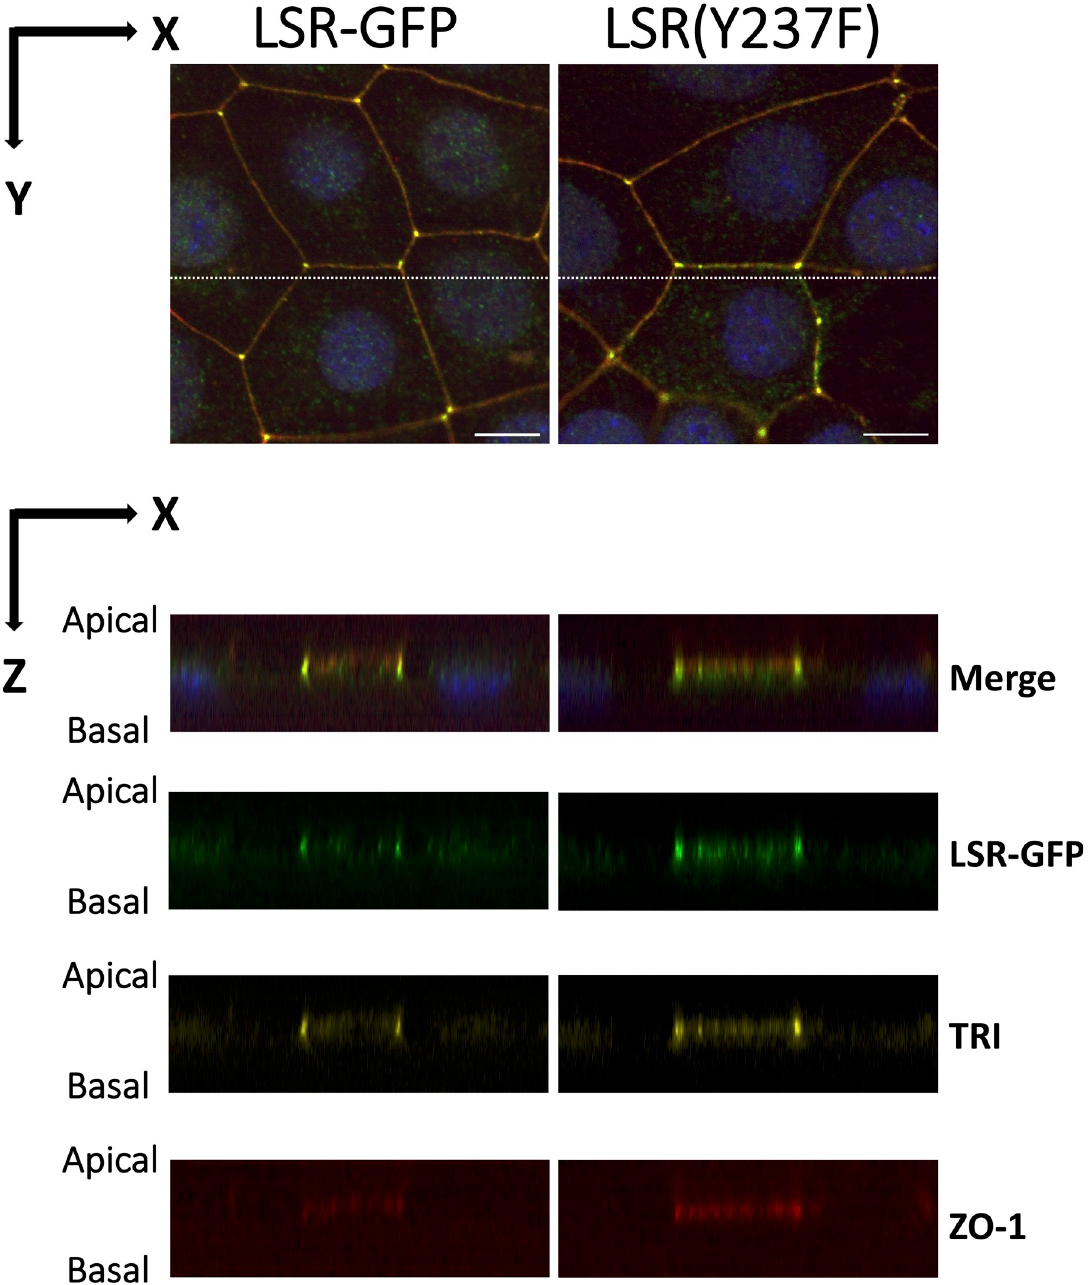
Fig 9. Three-dimensional subcellular localization of LSR and tricellulin in LSR-GFP or LSR(Y237F)-GFP expressed cells. EpH4 cells were treated under the same conditions as in Fig 8B. The cells were then immunostained with anti-tricellulin (TRI) and ZO-1 antibodies and counterstained with DAPI, and three-dimensional images of the cells were prepared as described in the Materials and Methods. We identified the three-dimensional subcellular localization of LSR-GFP, LSR(Y237F)-GFP and TRI in LSR-GFP or LSR (Y237F)-GFP expressed cells using the images. Imaging along the z-axis at the indicated position (white dotted line, upper panel) reveals colocalization of LSR(Y237F)-GFP and TRI with ZO-1 at bTJs in LSR(Y237F)-GFP expressed cells (lower panel). Bar, 10 μ m.